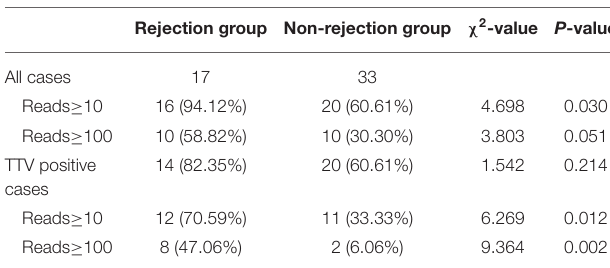
TABLE 4 | Relationship between viral infection and rejection after renal